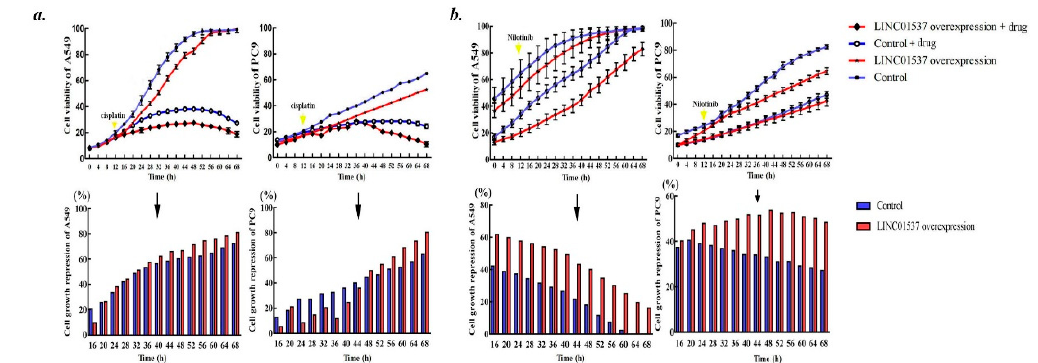
Figure 4. Biological e ff ects of LINC01537 on chemosensitivity. Cell viability was directly determined using the IncuCyte ® Live Cell Analysis Imaging System. ( a ) . Cisplatin was added to the cell culture medium. ( b ) . Nilotinib was added. Circle dot on line (Up) or bar height (Down) corresponds to the mean, and error bars represent the SD for five biological replicates. Cell growth repression = OD(cells without Drug treatment)-OD(cells with Drug treatment)/OD(cells without Drug treatment).